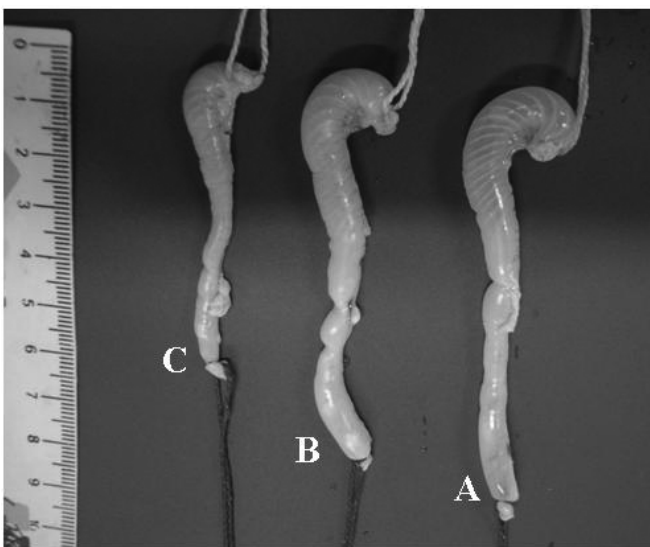
Values expressed as mean ± standard deviation. There was no statistic differ- ence among the values observed in the different groups at the times evaluated.